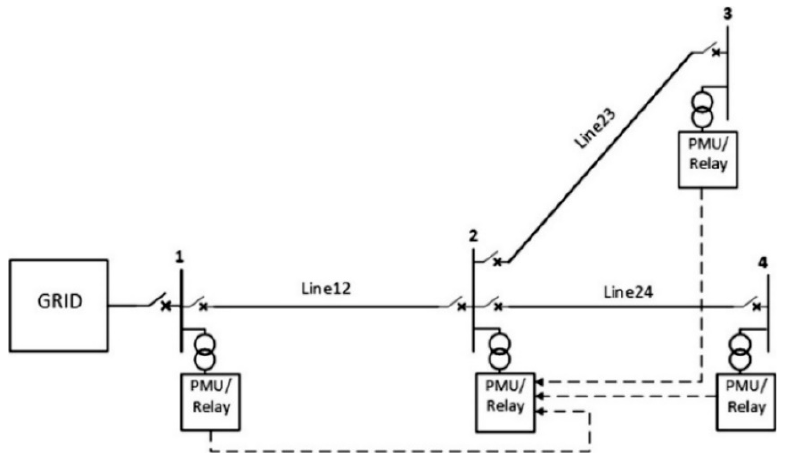
Figure 2. Application of a new type of voltage relays based on PMU [69].